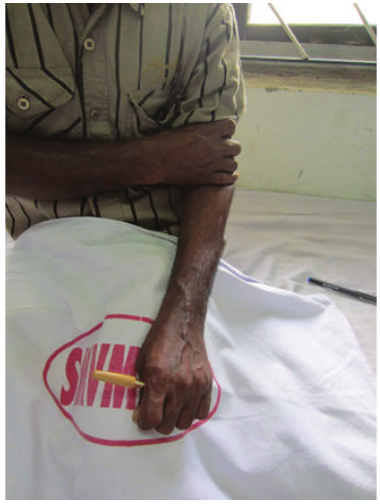
Figure 15: ROM (pronation) at 1-year followup.